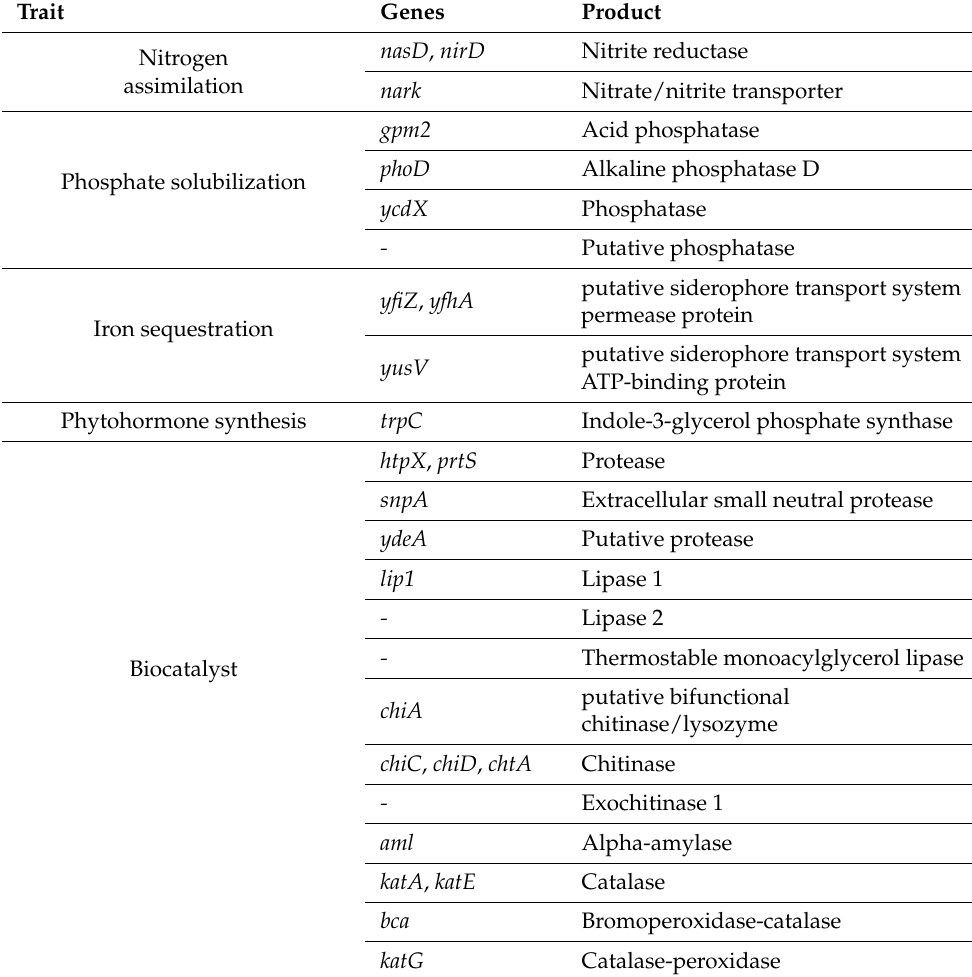
Table 2. Some genes related to the plant growth promotion and their representation within Strepto- myces vinaceusdrappus strain AC-40 according to Prokka annotations.